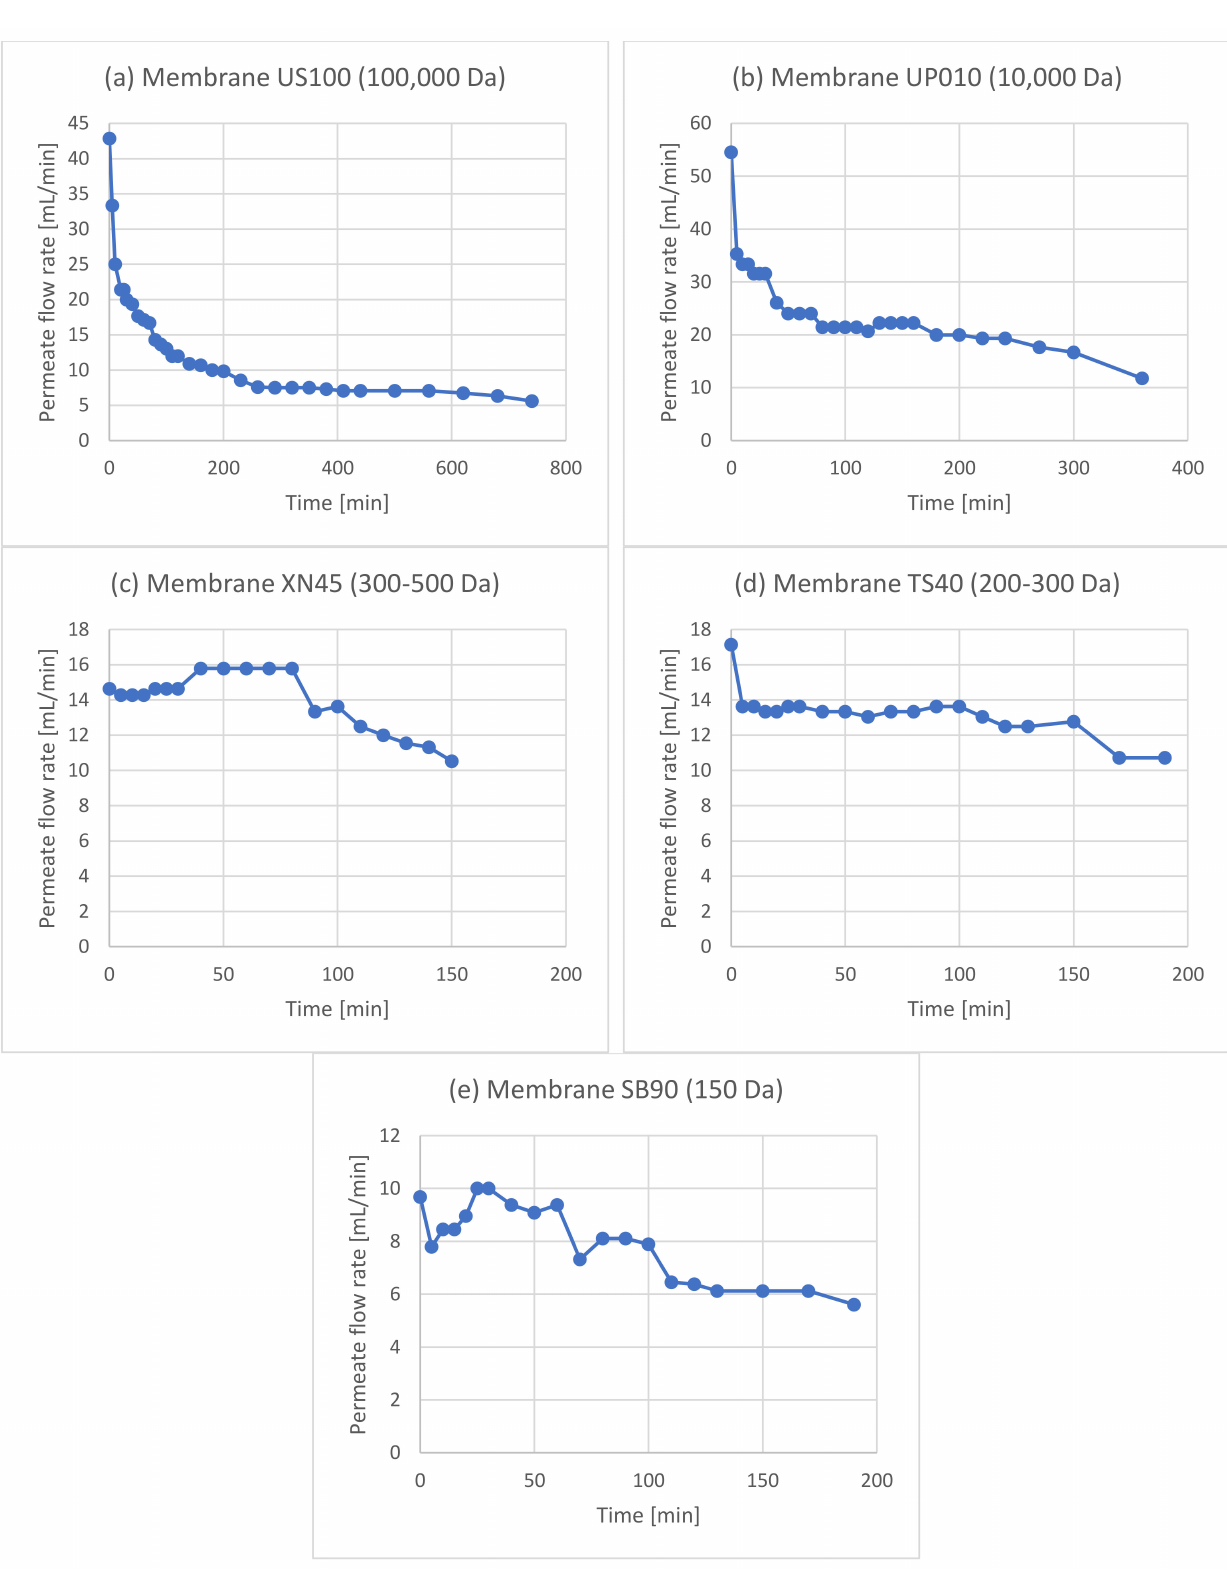
Figure A3. Permeate flow rates observed in the membrane treatment scheme after hydrolysis in which two ultrafiltration steps (( a ) US100, ( b ) UP010) were used in line and the permeate from the 10,000 Da membrane was split into three equal parts and was treated with three different nanofiltration membranes (( c ) XN45, ( d ) TS40, ( e )